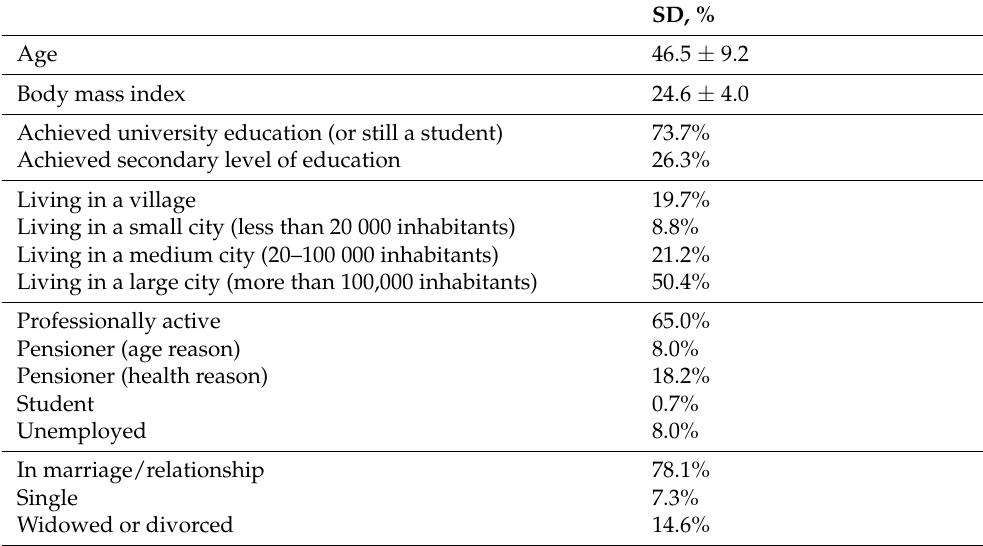
Table 1. Characteristics of the respondents ( n = 138).